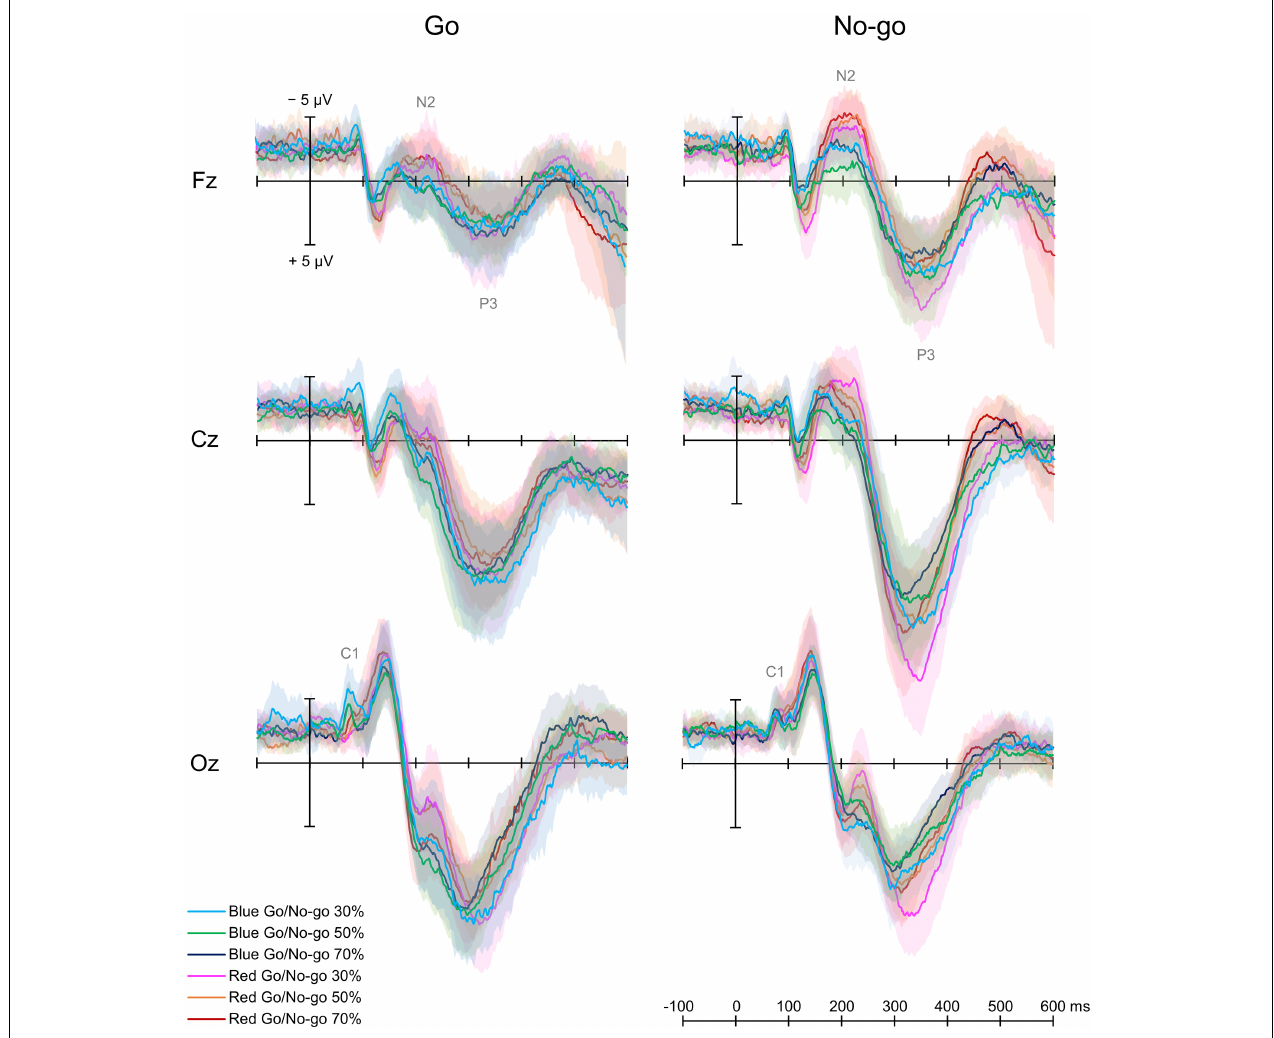
FIGURE 3 | Grand average event-related potential waveforms. There were six conditions created by crossing two target colors (Blue Go/Red No-go and Red Go/Blue No-go) and three target probabilities (30, 50, and